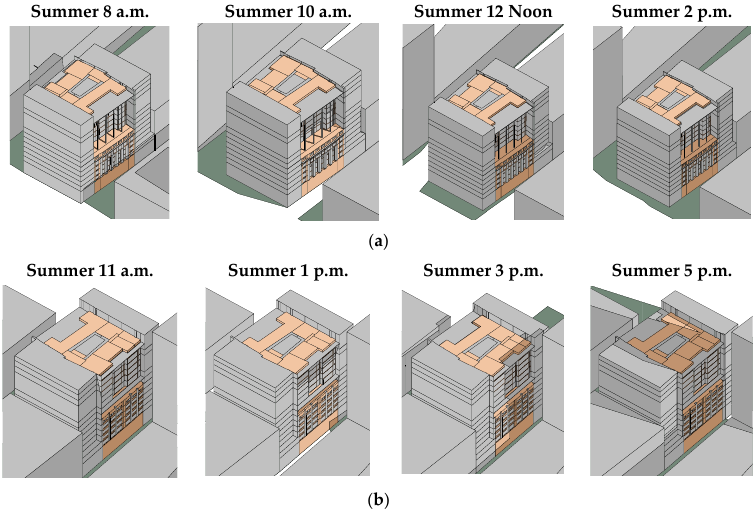
Figure 3. APACHE simulation model eastern shading analysis: ( a ) eastern facade; ( b ) western facade.